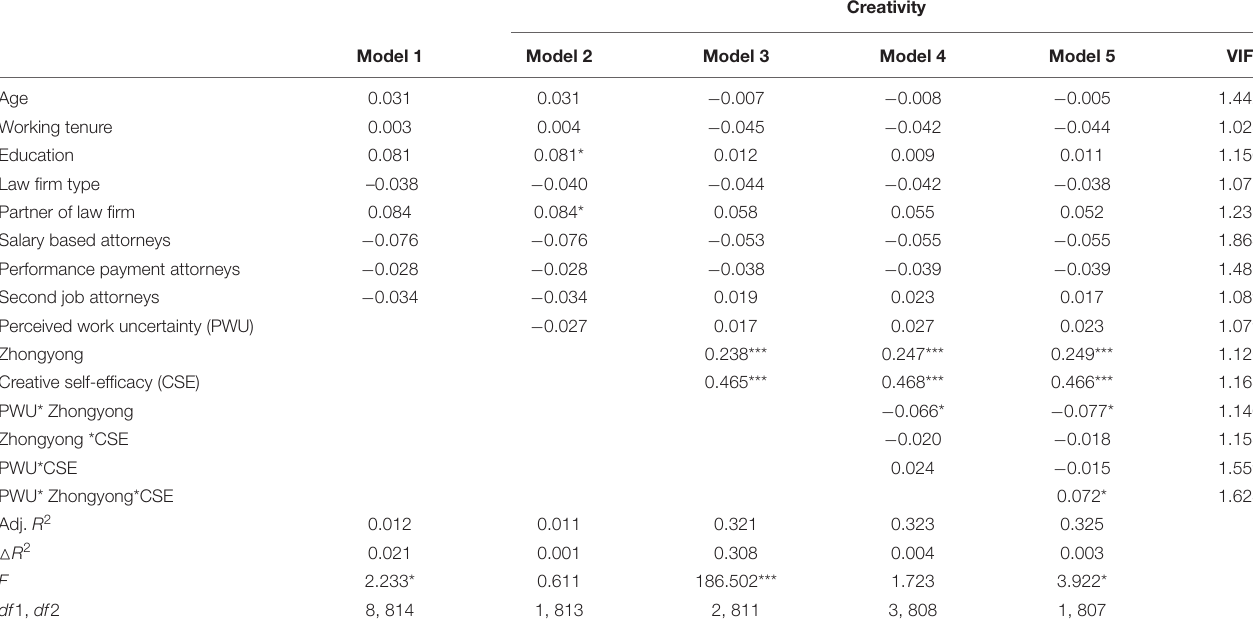
TABLE 5 | Results of hierarchical regression analysis of hypothesized effects on